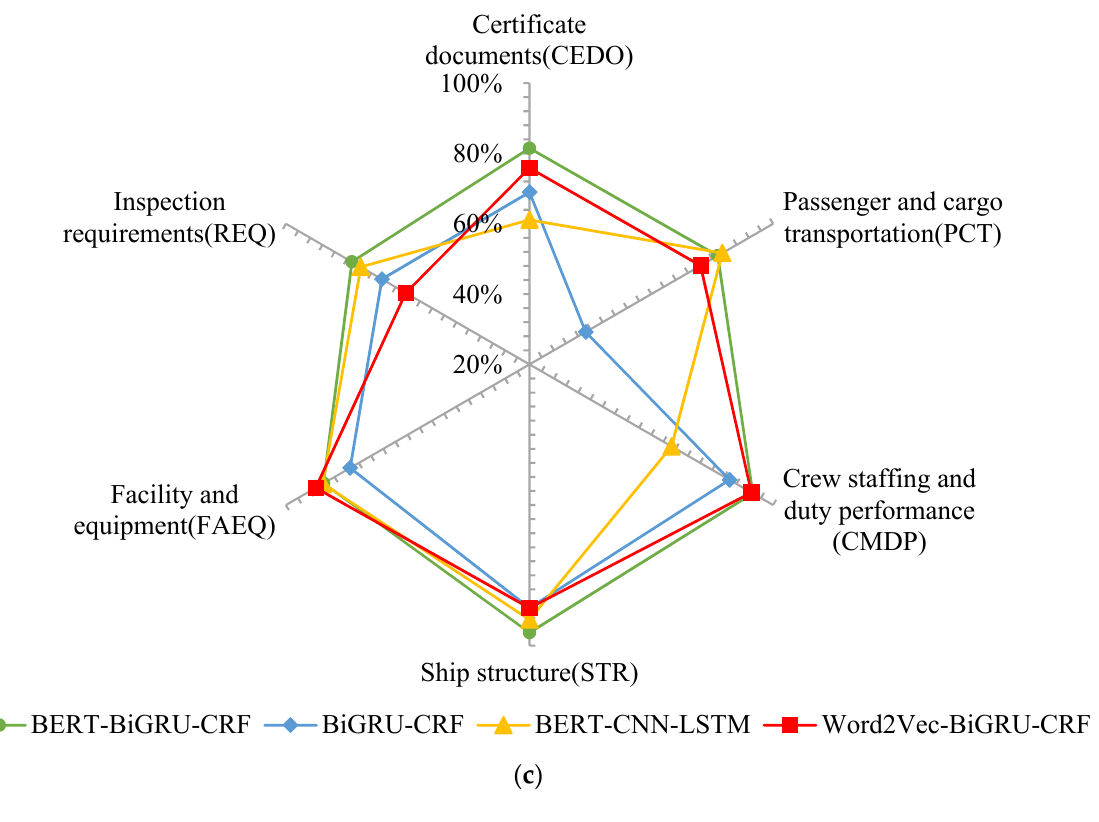
Figure 7. P , R , and F 1 values of different entities in different models. ( a ) P values; ( b ) R values; ( c ) F 1 values.